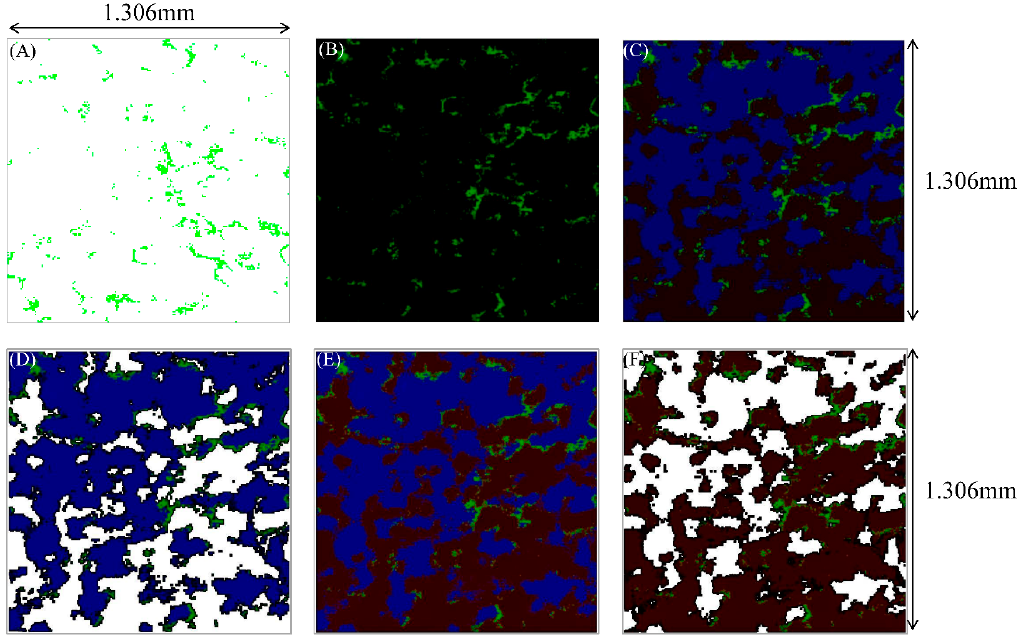
Figure 7. Multi-components distribution. Green, black, blue, red, and dark brown denote organic matter, pore, Minerals 1, Minerals 2, and a mixture of Minerals 1 and Minerals 2, respectively. ( A ) Two-dimensional slice of organic matter; ( B ) Distributions of organic matter and pore; ( C ) Distributions of organic matter, porosity, and minerals; ( D ) Distributions of organic matter and Minerals 1; ( E ) Distributions of organic matter, Minerals 1, and Minerals 2; ( F ) Distributions of organic matter and Minerals 2.